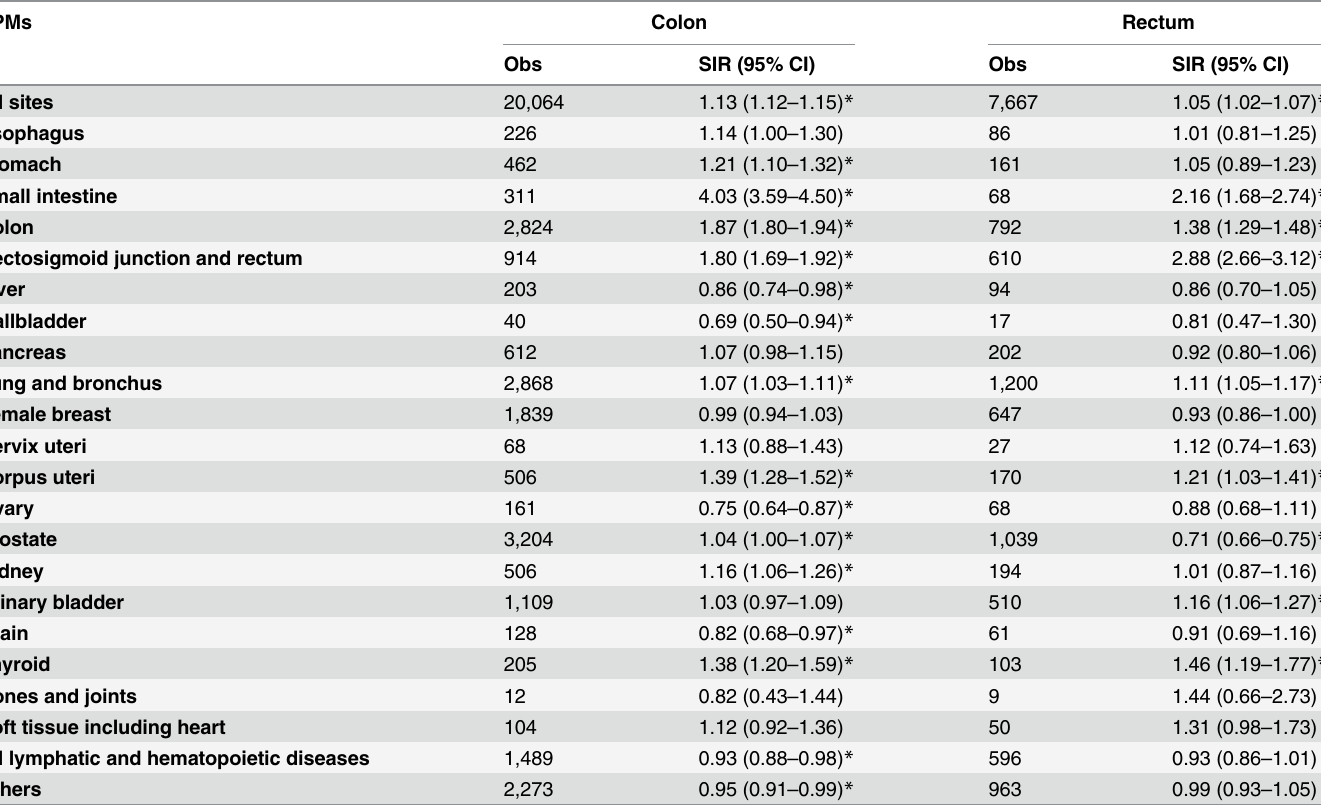
Table 2. Risk of SPMs in colon and rectal cancer